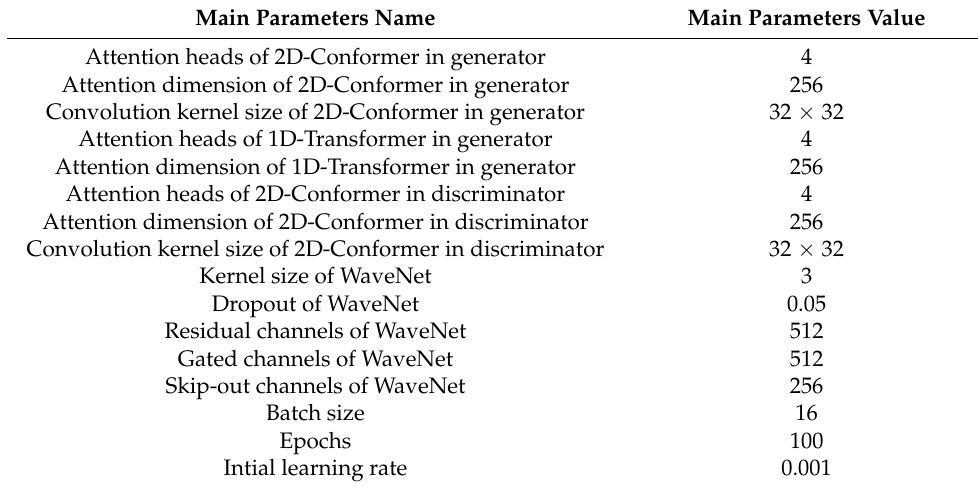
Table 1. Hyper Parameters of proposed